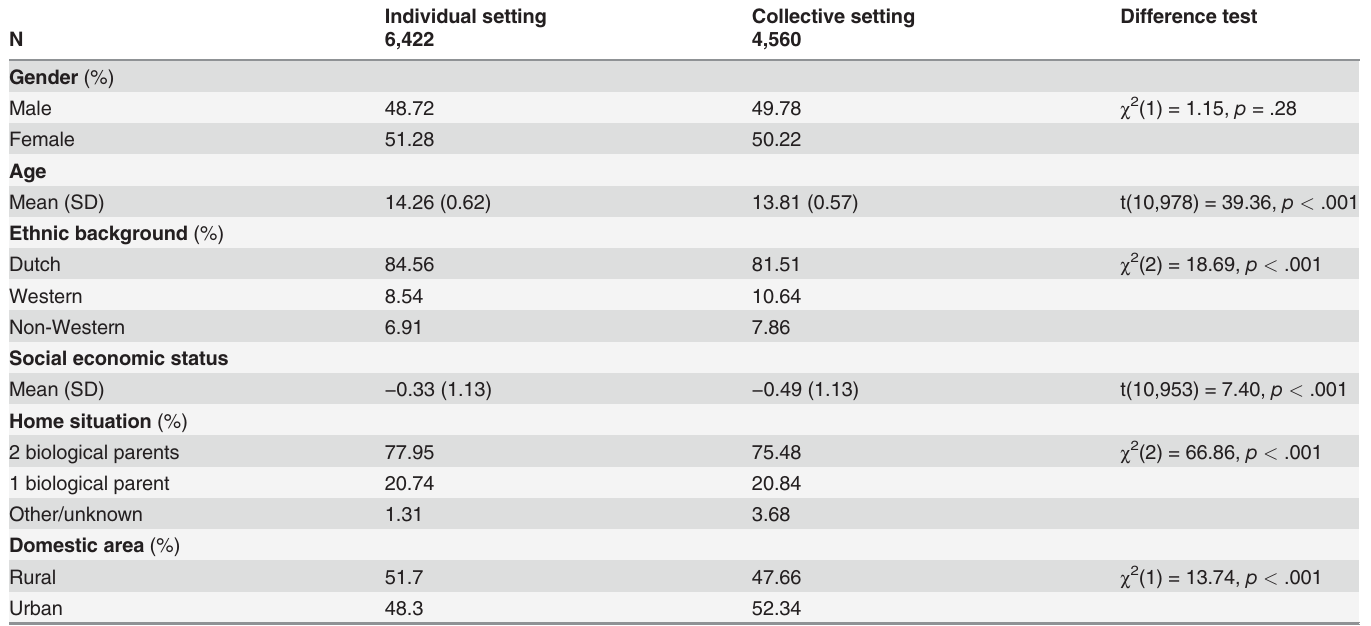
Table 1. Background characteristics for the samples of the individual and collective